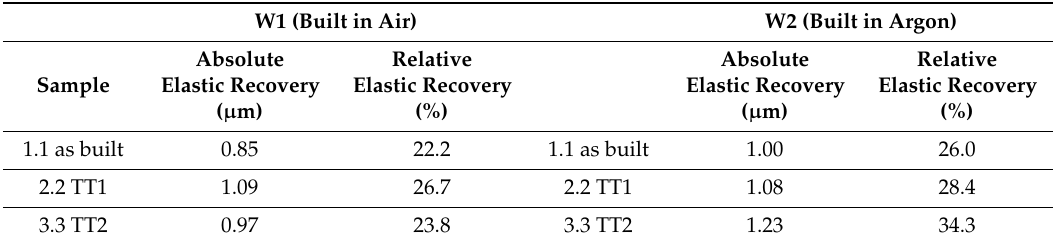
Table 6. Elastic recovery values employing a load of 1